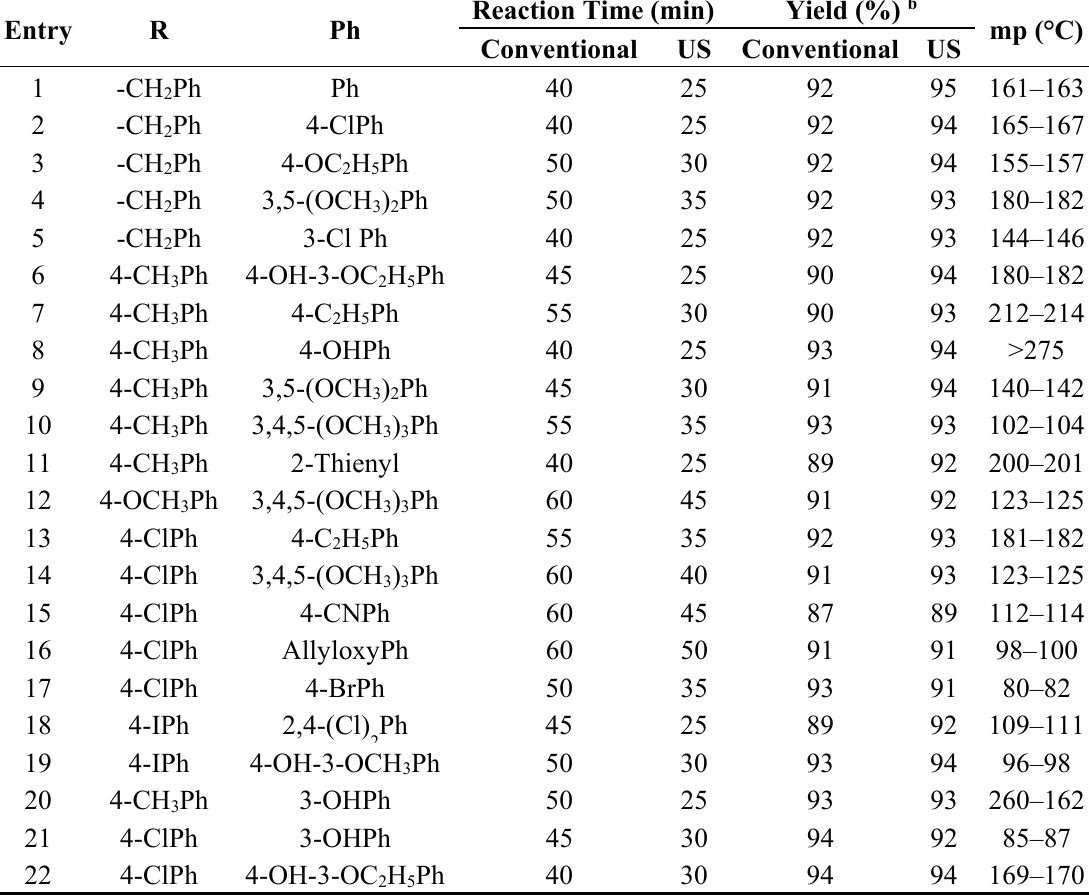
Table 4. Synthesis of tetraaryl imidazoles ( 1 – 22 ) a